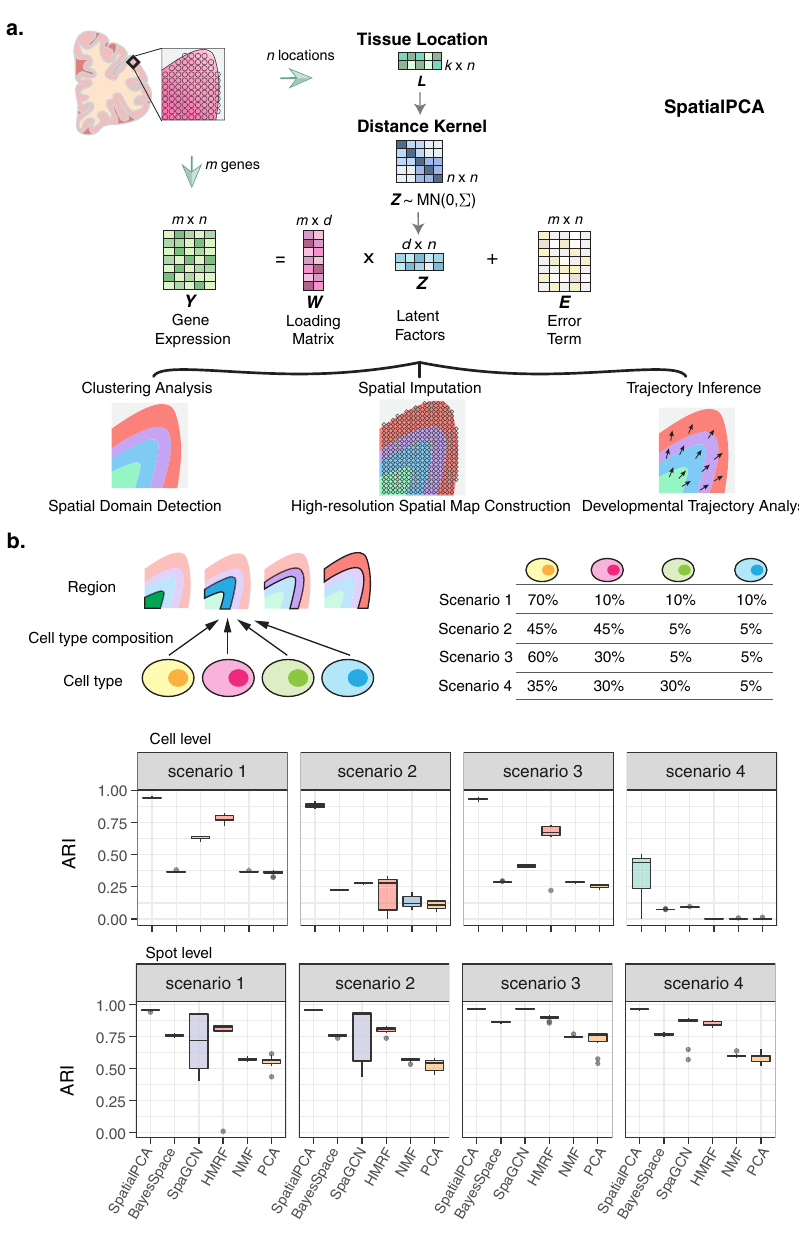
Fig.1|MethodschematicofSpatialPCAandsimulationresults.a SpatialPCAisa spatiallyawaredimensionreductionmethodthattakesbothgeneexpression Y and location information L as inputs. It models the gene expression matrix Y as